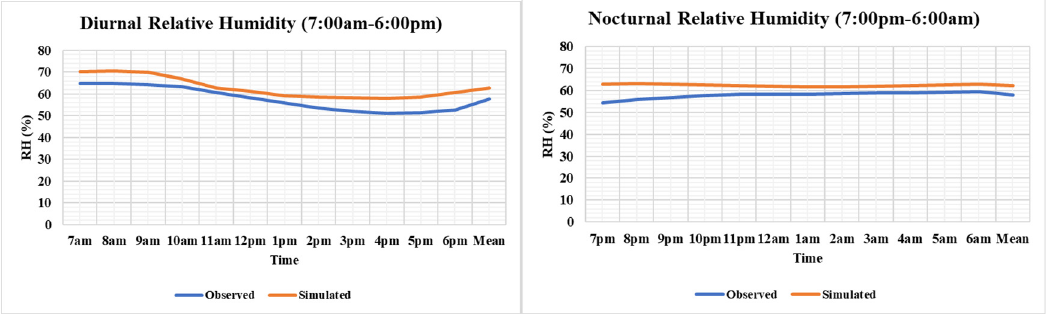
Figure 6. Measured and simulated results of diurnal and nocturnal relative humidity at